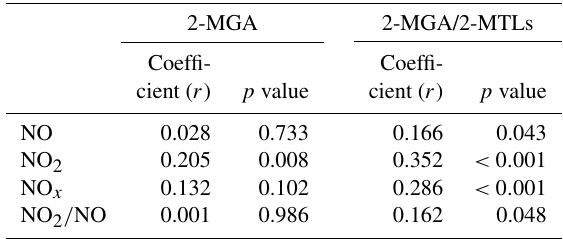
Table 1. Correlations between SOA I tracers and NO x